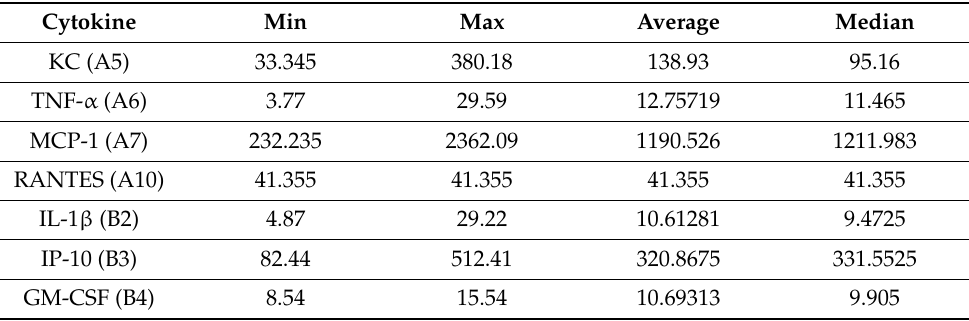
Table 3 presents data for liquid biopsy cytokines extracted from pretreatment blood serum. Similar to Table 2, minimum, maximum, average, and median values are reported. The only statistically significant cytokine associated with the observed CD45 difference was granulocyte-macrophage colony-stimulating factor (GM-CSF). Table 3. Descriptive statistics on the liquid biopsy cytokines derived from the blood serum derived from the pretreatment blood